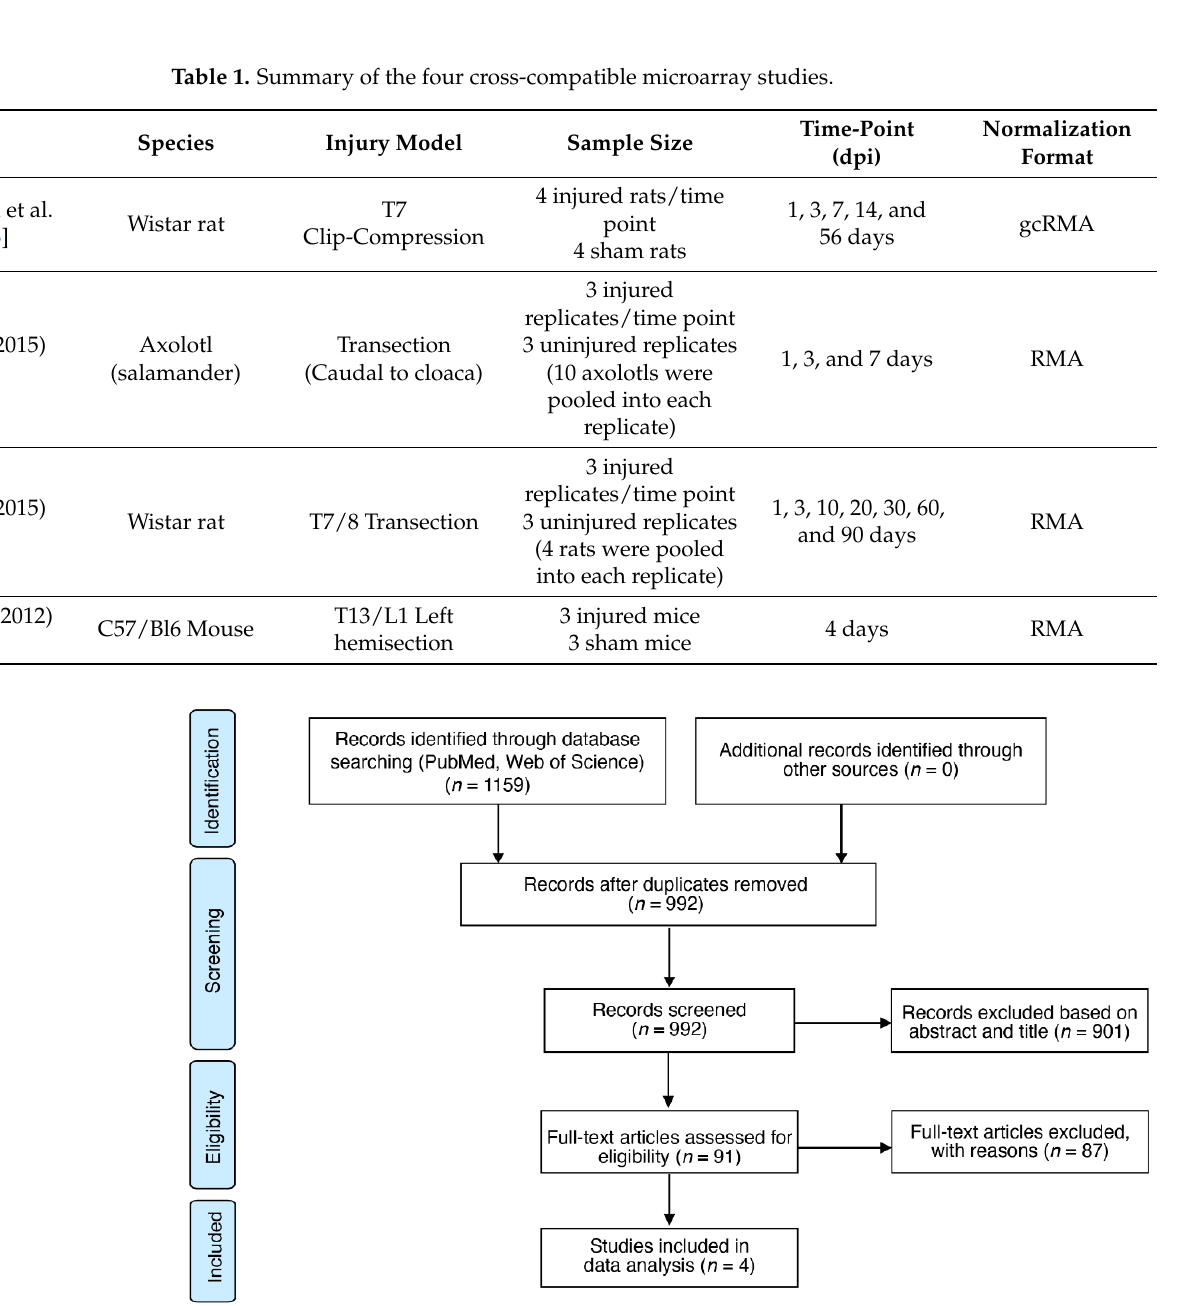
Figure 1. Search strategy flowchart. A PRISMA flowchart summarizing the search strategy used to identify articles with open-source SCI transcriptome databases in rats, mice, and salamanders [30]. A total of four cross-compatible microarray studies were isolated to be included in the final analysis.